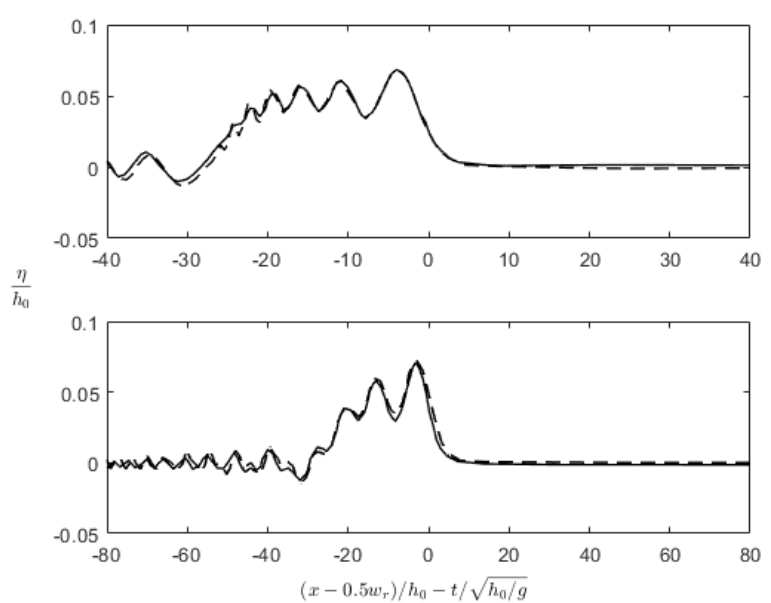
Figure 2. Surface waves generated by a rectangular disturbance with height h r and width w r : snapshots of free-surface displacement, η , normalized by the constant water depth, h 0 , presented in a moving coordinate. Solid line: present solutions. Dashed line: numerical results by Boussinesq model reported by Madsen, Fuhrman, and Schäffer [25]. Upper and lower panel plot the results at dimensionless time (cid:112) t / h 0 / g = 35 and 90, respectively. In this case, h r / h 0 = 0.1 and w r / h 0 = 24.4. The horizontal and vertical resolutions in our calculations are 0.02 m and 0.009374 m, respectively, and ∆ t = 0.01 s is used.